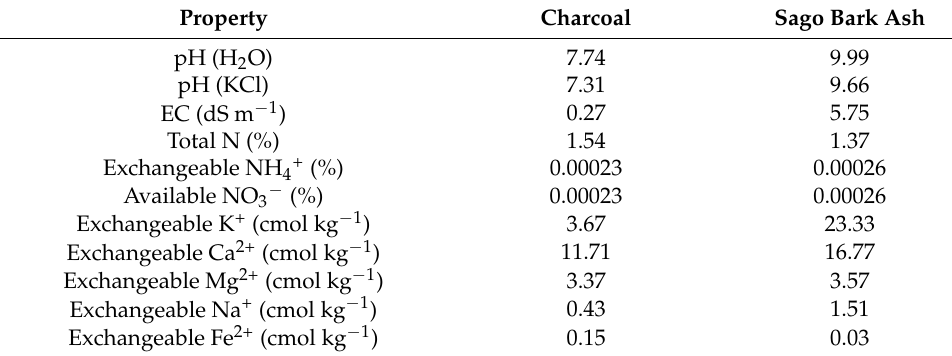
Table 2. Initial characterization for selected chemical properties of charcoal and sago bark ash used in the incubation study.